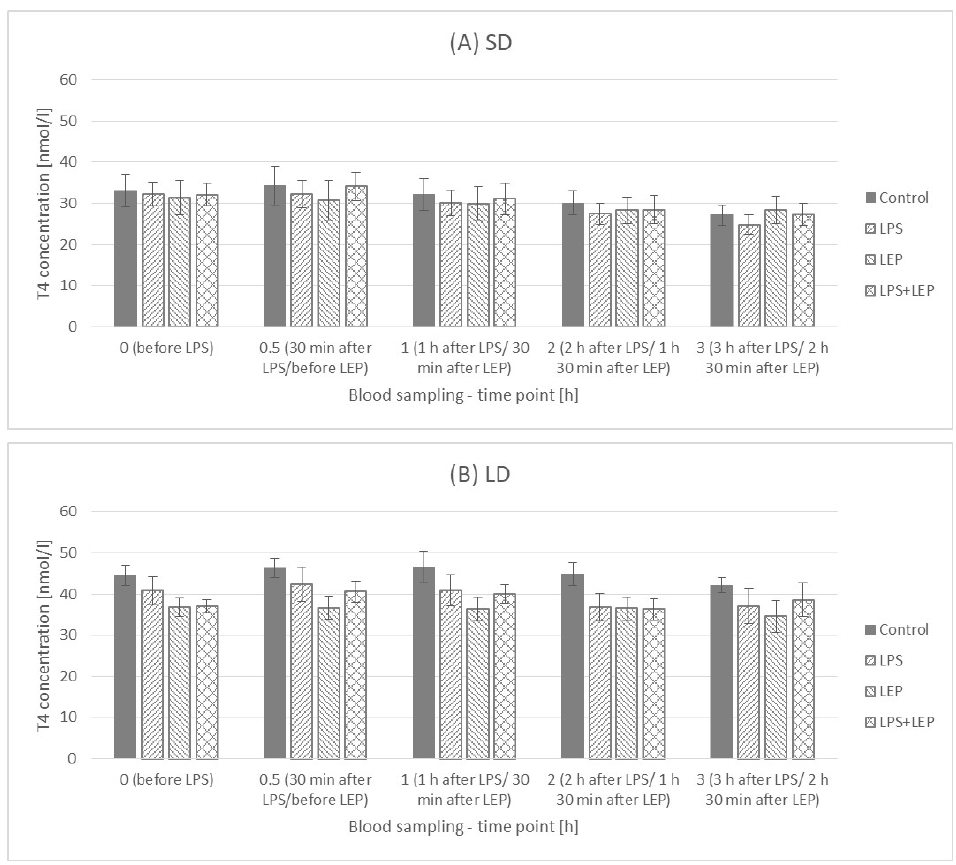
Figure 12. Plasma thyroxine (T4) concentration—comparison among the experimental groups (con- trol, LPS, LEP and LPS + LEP) for the short-day (SD) ( A ) and long-day (LD) ( B ) photoperiods for each selected time point separately; n = 6. Groups: control—saline injection, LPS—lipopolysaccharide injection at a dose of 400 ng/kg of body mass at a 0 h time point, LEP—leptin injected at a dose of 20 µ g/kg of body mass at a 0.5 h time point, LPS + LEP—LPS and LEP injections at the same doses and time points as those in the LPS or LEP groups.